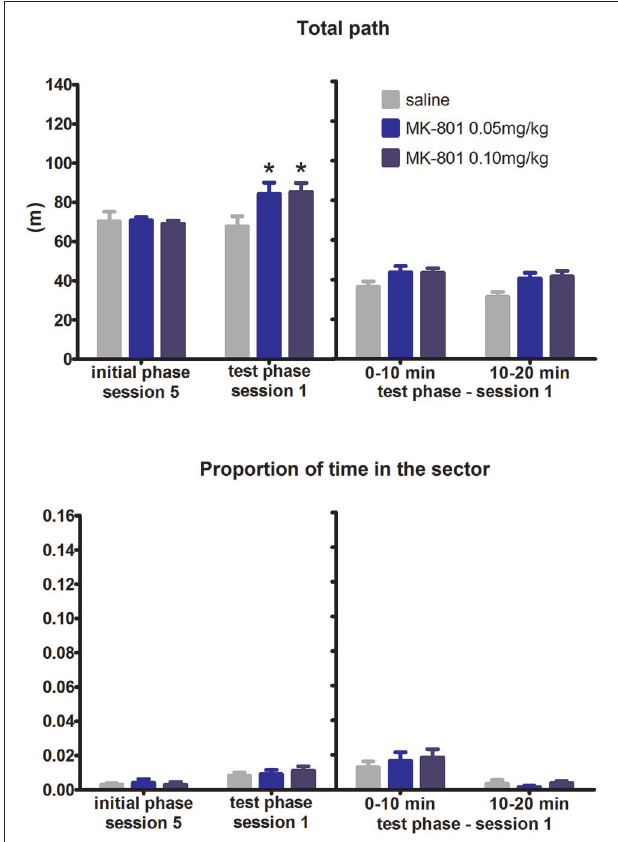
FIGURE 2 | Performance of the rats in condition 1 (motor response switch) . Upper graph indicates total path elapsed during the last session of the initial phase, first session of the test phase, and its split into two 10 min segments (group means ± SEM). Lower graph shows proportion of session time spent in the prohibited sector. Difference between the session 1 of the test phase and the session 5 of the initial phase were computed as difference scores and the resulting statistics is provided. * P < 0.05 compared to saline